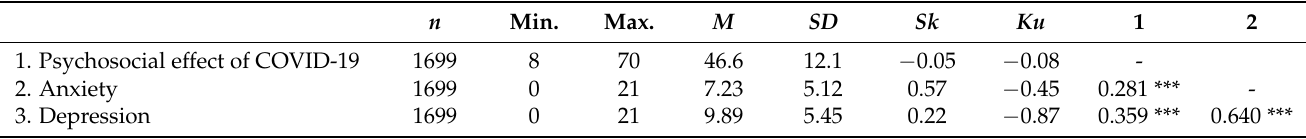
Table 1. Correlations Between Adversity and Adaptation